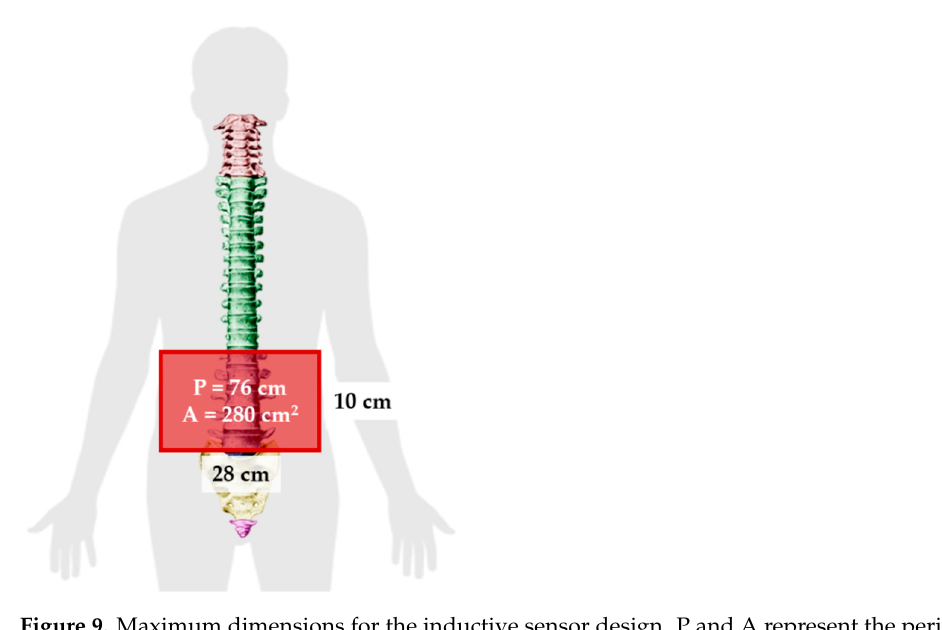
Figure 9. Maximum dimensions for the inductive sensor design. P and A represent the perimeter and the area, respectively. This image is licensed under a Creative Commons Attribution-Share Alike license (CC BY—SA) [35,36].